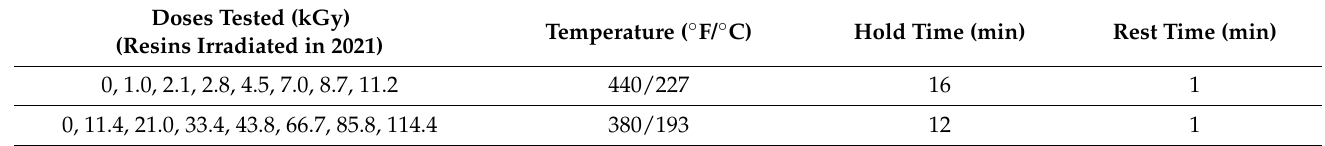
Table 3. Testing matrix (Loading Force: 6672 N (1500 lbf)).